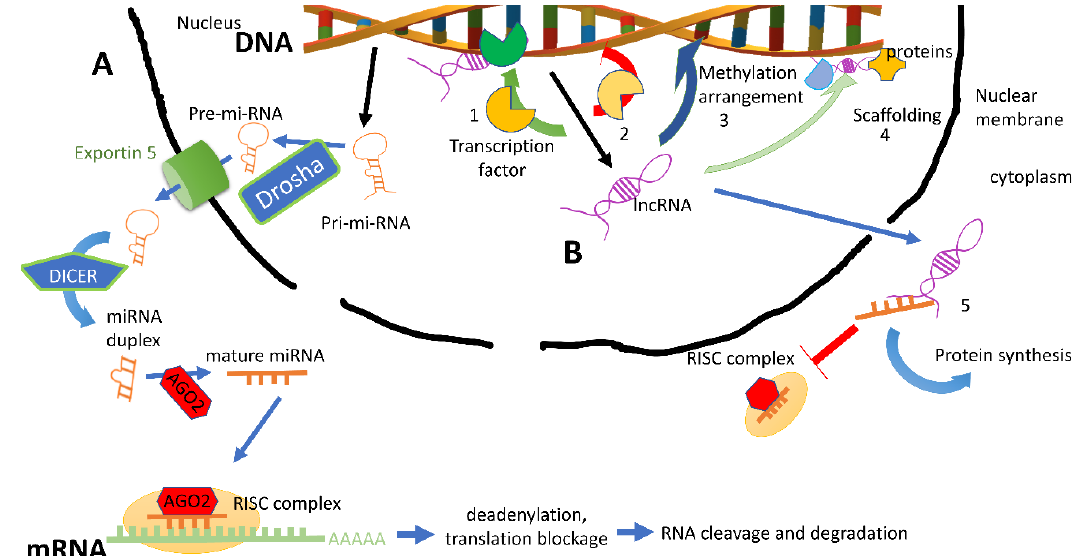
Figure 1. Cartoon summarizing the actions of microRNAs (miRNAs) and long non-coding RNAs (lncRNAs) in the cell. The processes of biogenesis and sorting in the cellular compartment as well as the interaction with molecular partners are highlighted. ( A ) Drosha, a nuclear endonuclease, converts the hairpin-loop RNA primary transcript into a shorter stem-loop structured pre-miRNA. After nuclear export by exportin 5, Dicer cleaves the pre-miRNA stem-loop into an RNA fragment with a two-nucleotide 3 (cid:48) overhang at each end. Thereafter, the mature miRNA is loaded into the RISC complex by AGO proteins (mainly AGO2). Finally, the target mRNA is sorted and processed for cleavage. ( B ) LncRNA can work in the nucleus or can be exported into the cytoplasm. In the nucleus, lncRNA can act as (1) signaling, synergistically cooperating with a transcription factor to finely regulate in time and space the gene expression; (2) decoy, undermining a transcription factor; (3) guide, recruiting chromatin-modifying enzymes on a target gene; or (4) sca ff old, favoring the formation of a complex or a spatial proximity of two or more proteins. When lncRNA is exported into the cytoplasm, it can sequester a miRNA, acting as a sponge (5), avoiding the assembly of RISC complex and favoring the translation of the mRNA into a